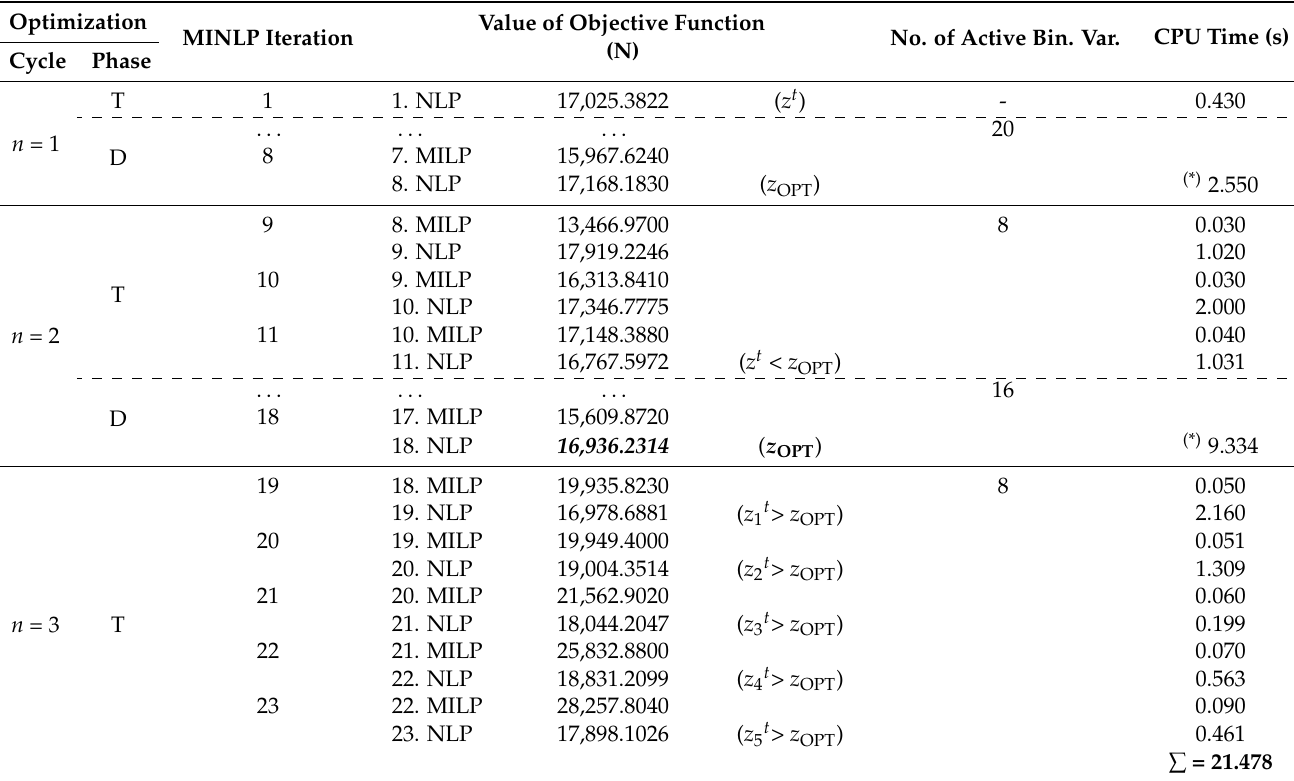
Table 4. Convergence of the Modified OA/ER algorithm and the STP strategy, example TC10b (topology and shape optimization, without buckling constraints).